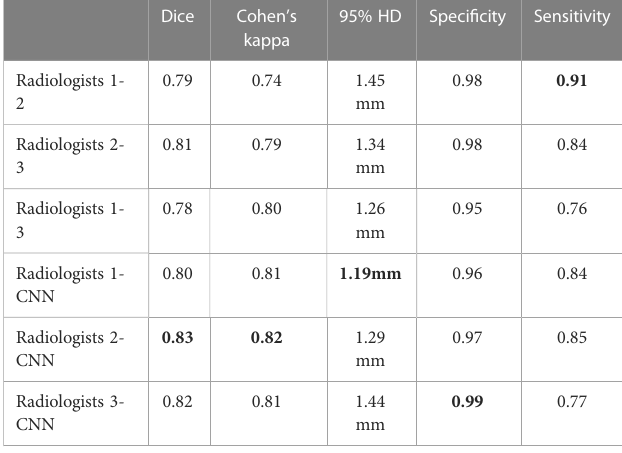
TABLE 3 Mean values of pairwise comparison metrics between all observers.